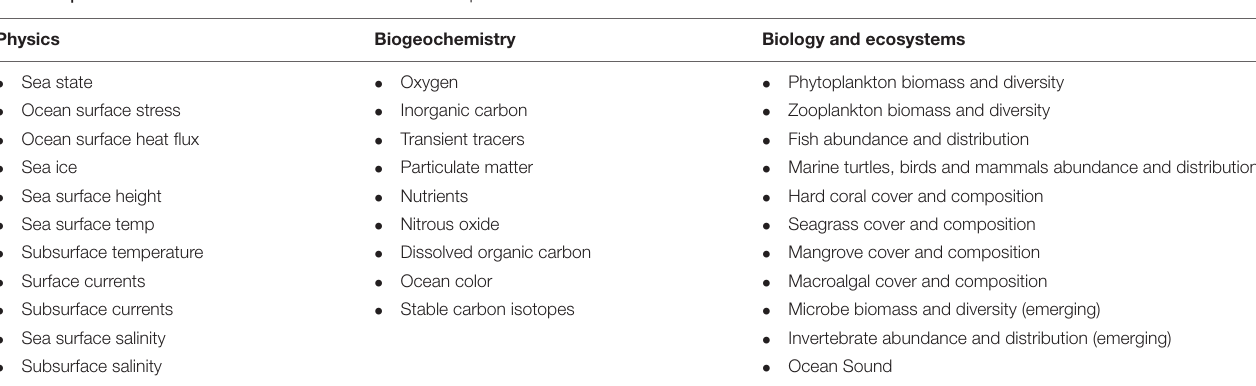
TABLE 1 | Essential Ocean Variables identified for each GOOS panel.